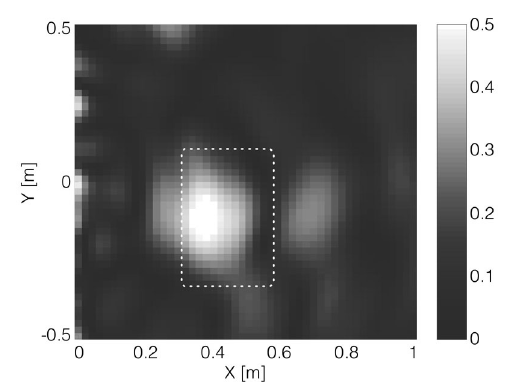
Fig. 6. Case 1: a rectangular void. Modulus of the reconstructed contrast when considering noise-cor- rupted data (SNR = 10